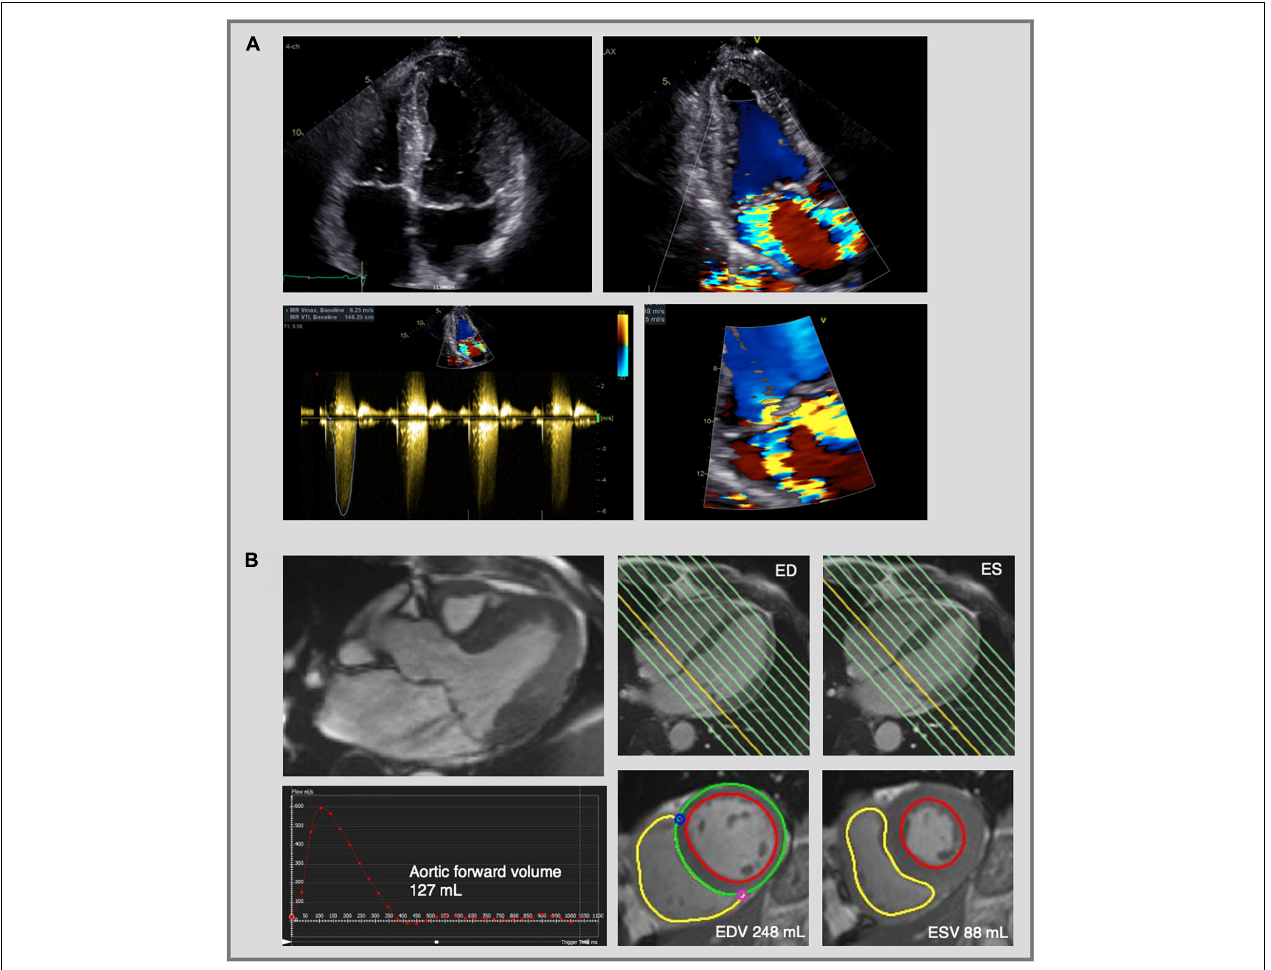
FIGURE 5 | Mitral regurgitation assessment by echocardiography and cardiac magnetic resonance imaging. Complex evaluation of moderate-severe mitral regurgitation (MR) with multiple jets in a patients with bileaflet mitral valve prolapse. (A) 2D transthoracic echocardiography using color flow Doppler shows two MR jets—an eccentric jet toward the intra-atrial septum and a jet toward the lateral wall. The PISA radius was measured at 8 mm, but given the multiple and eccentric jets, this parameter is not reliable to calculate the EROA and MR volume, which indicates the need for further evaluation using CMR. (B) CMR images of the same patient as in panel (A) . Three-chamber cine image shows the presence of MR with two jets (upper left image). MR volume was calculated at 33 mL using the indirect method based on the difference between LV stroke volume (EDV—ESV = 160 mL) and aortic forward volume (127 mL). The LV stroke volume was calculated from the short-axis cine images in end-diastole and end-systole (lower right images) and the aortic flow was calculated by phase-contrast imaging (lower left image). Traditionally the LV base is defined at the level of the mitral valve annulus (yellow line, upper right images) and therefore the calculated regurgitant volume includes both the transvalvular MR volume and the prolapse volume. MR, mitral regurgitation; PISA, proximal isovelocity surface area; EROA, effective regurgitant orifice area; CMR, cardiac magnetic resonance imaging; LV, left ventricle; ED, end-diastolic; ES, end-systolic; EDV, end-diastolic volume; ESV, end-systolic